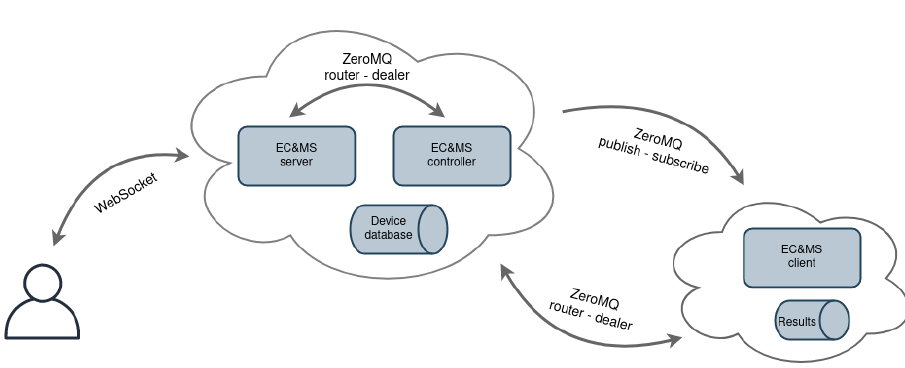
Figure 4. Experiment control and monitoring system reference